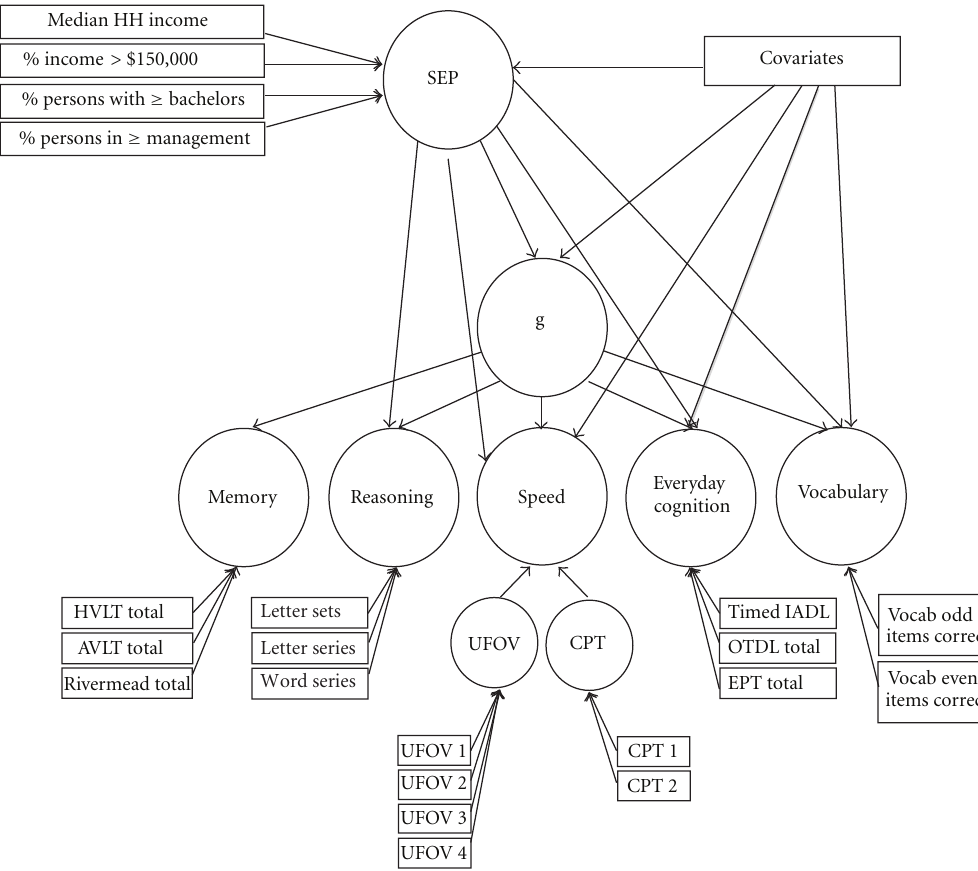
Figure 2: Schematic of the predictive model of baseline cognition. Regression paths were estimated from all covariates (gender, age, education, and race) to g, reasoning, speed, everyday cognition, and vocabulary, and could not be estimated for memory. Model covariates included age, quadratic age, education, gender, and race. HH =